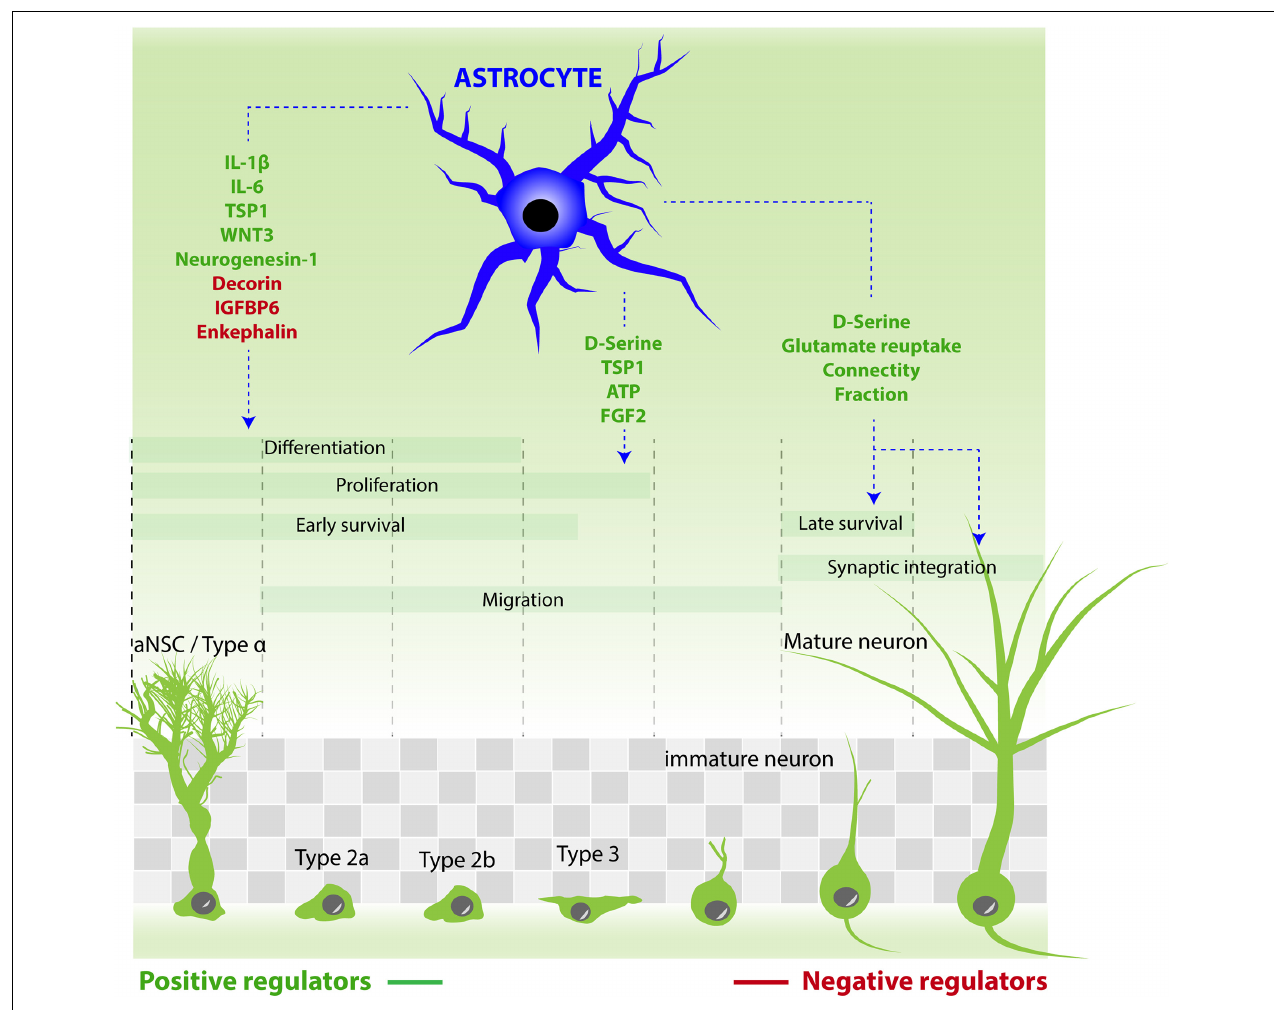
FIGURE 2 | Astrocytes contribution to the different steps of adult neurogenesis by releasing active molecules. Molecules that stimulate aNSC/progenitor cell proliferation: ATP, D -serine, FGF2, TSP1. Molecules that increase neuronal differentiation: TSP1, neurogenesin-1, IL-1 β , IL-6, and WNT3. Molecules that reduce neuronal differentiation: IGFBP6, enkephalin, decorin. Molecules that increase neuronal maturation and synaptic integration: D -serine. Astrocytes also regulate the synaptic integration of new neurons by reducing connectivity fraction and glutamate